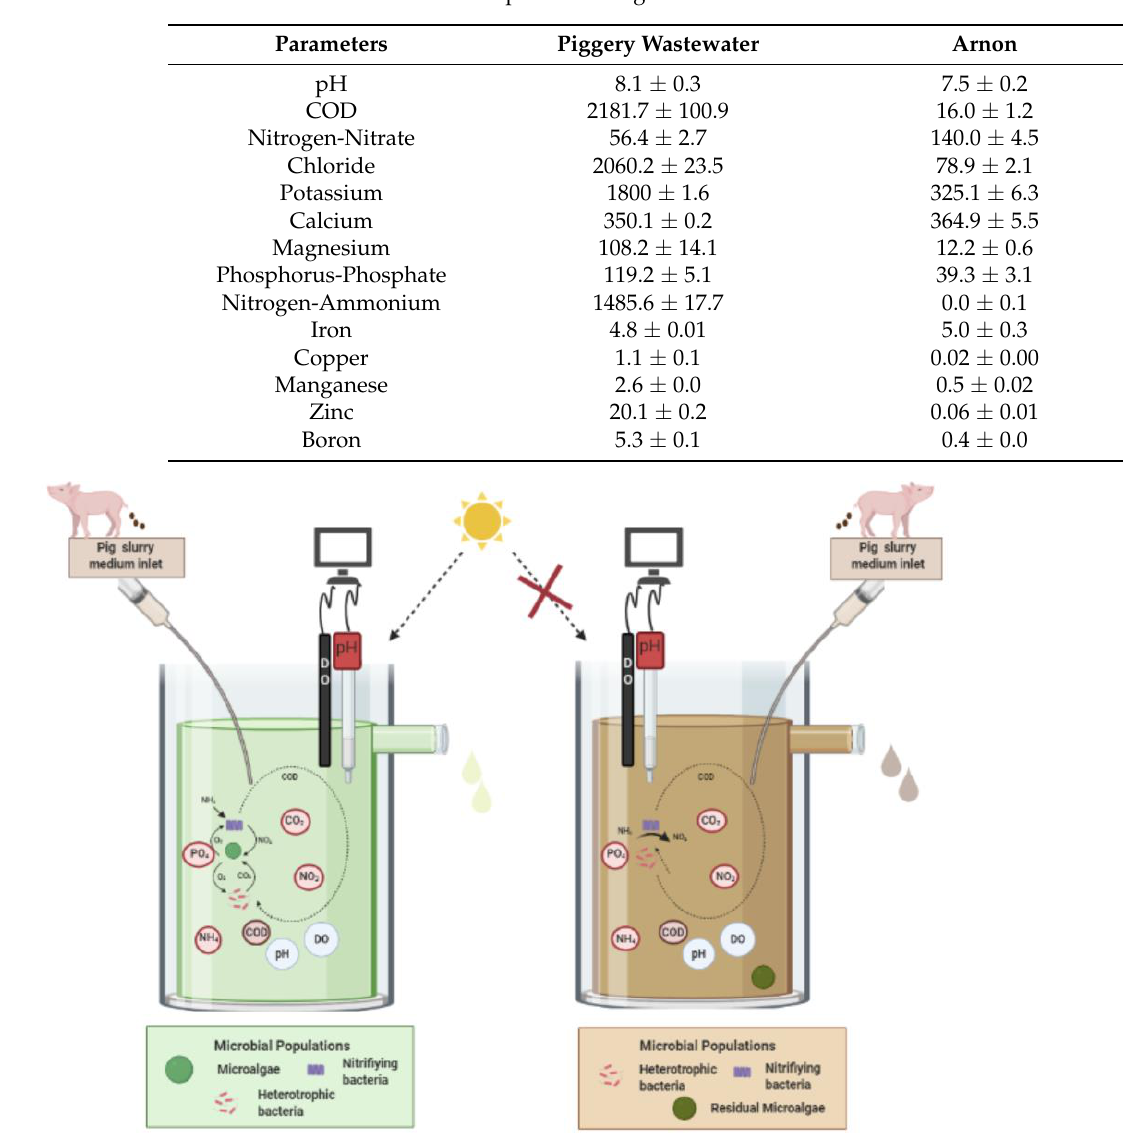
Table 1. Average composition of the culture medium and piggery wastewater used as the influent in the bioreactors. Concentrations expressed as mg · L − 1 .